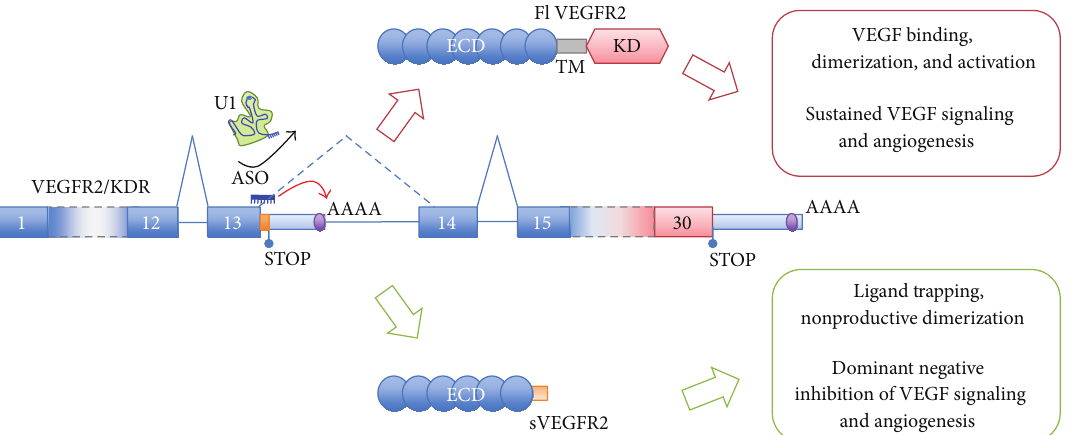
Figure3:TherapeuticpotentialofIPAactivation:inductionofsecreteddecoyVEGFR2.AnIPAsiteinintron13ofVEGFR2canbespecifically and effectively activated using ASOs targeted to the 5 󸀠 ss immediately upstream, preventing U1 from binding and thus releasing suppression [19]. This leads to the expression of a variant secreted decoy VEGFR2 encoding the sole ECD. This variant can still bind VEGF or other ligands and can still dimerize with VEGF receptors, but it cannot signal. On the contrary, it leads to a blockade of VEGF signaling in targeted and surrounding cells, with dominant negative